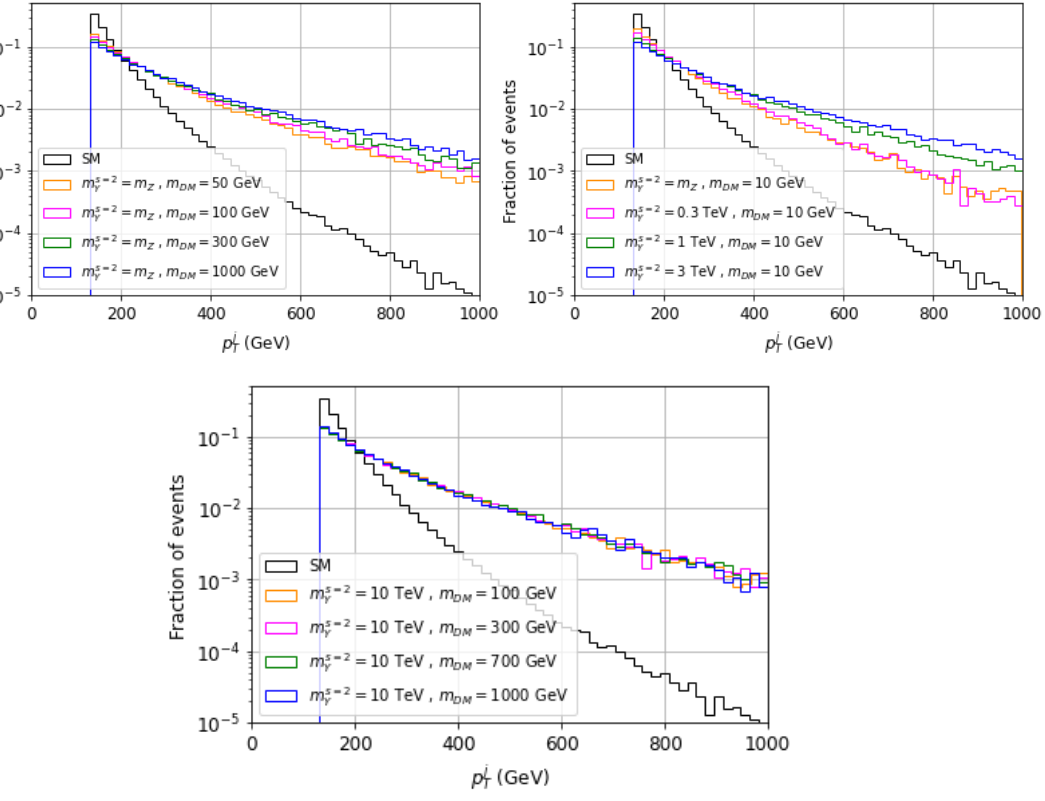
distribution of the spin-2 mediator framework, Figure 25: Space described by the p j T off-shell (top-left panel), on-shell (top-right panel), and off-shell PS (bottom panel) regime, at parton